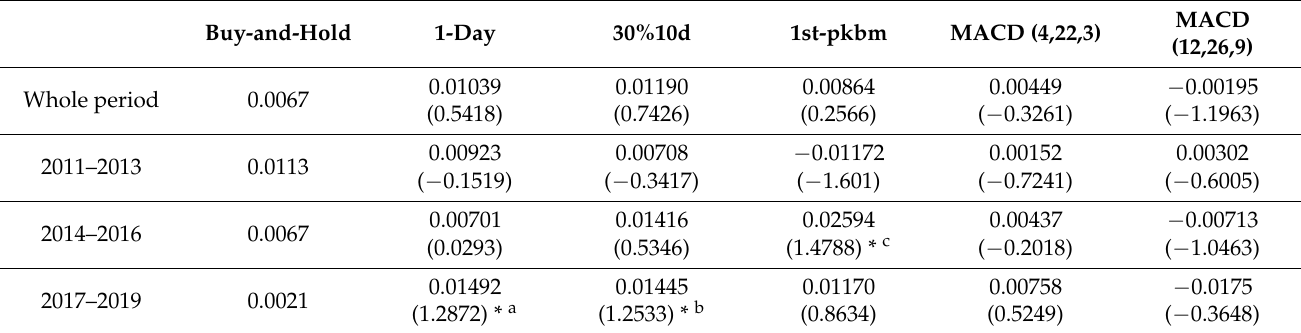
Table 13. t -test Comparisons of the Five MACD Models vs. the Buy-and-Hold Strategy.